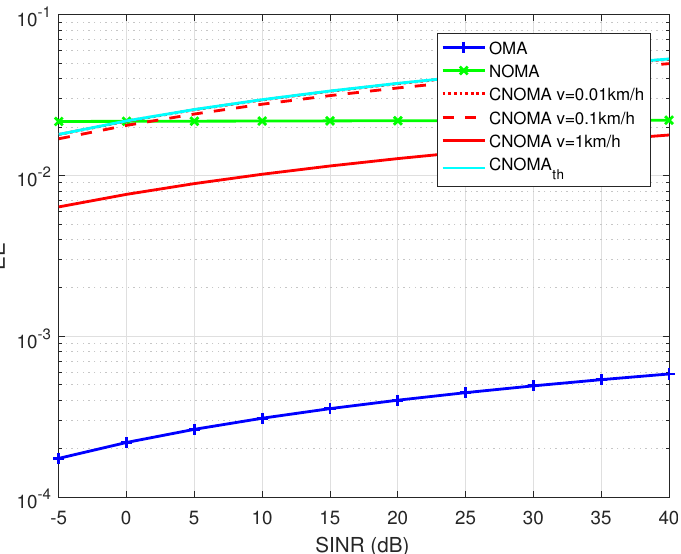
Figure 6. EE comparison between OMA, NOMA and proposed cooperative NOMA. N = 1566 and M =